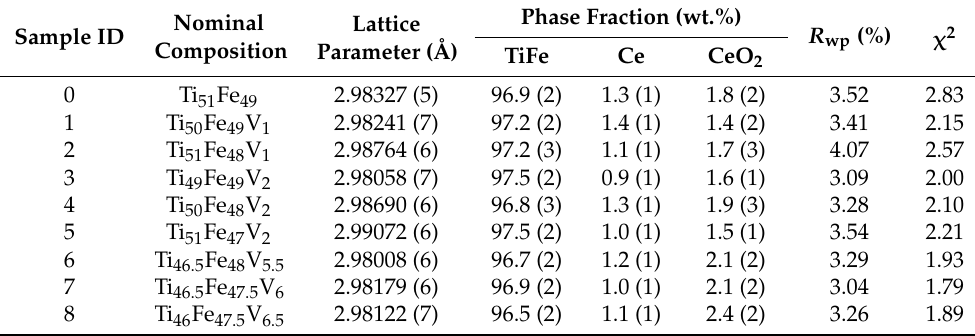
Figure 2. WPF plot for the XRD data from samples: ( a ) 0; ( b ) 1; ( c ) 2; ( d ) 3; ( e ) 4; ( f ) 5; ( g ) 6; ( h ) 7; ( i ) 8. The peaks of TiFe, Ce, and CeO 2 were indexed. Observed intensity (I obs ), calculated intensity (I cal ), and the difference (I obs –I cal ) were plotted in black circles, red line, and blue line, respectively. Table 2. XRD analysis of the samples. The lattice parameter of the TiFe main phase and the phase fractions determined by the Rietveld refinement of the XRD data in Figure 2. The weighted profile R -factor ( R wp ) and the goodness of fit ( χ 2 ) are listed to show the quality of the